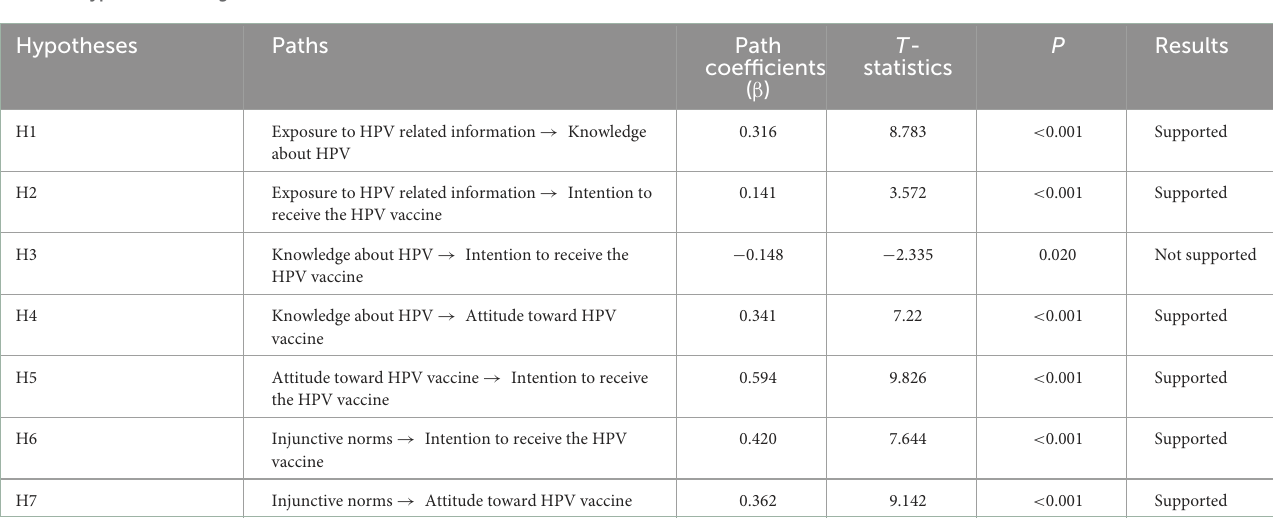
TABLE 7 Hypothesis testing